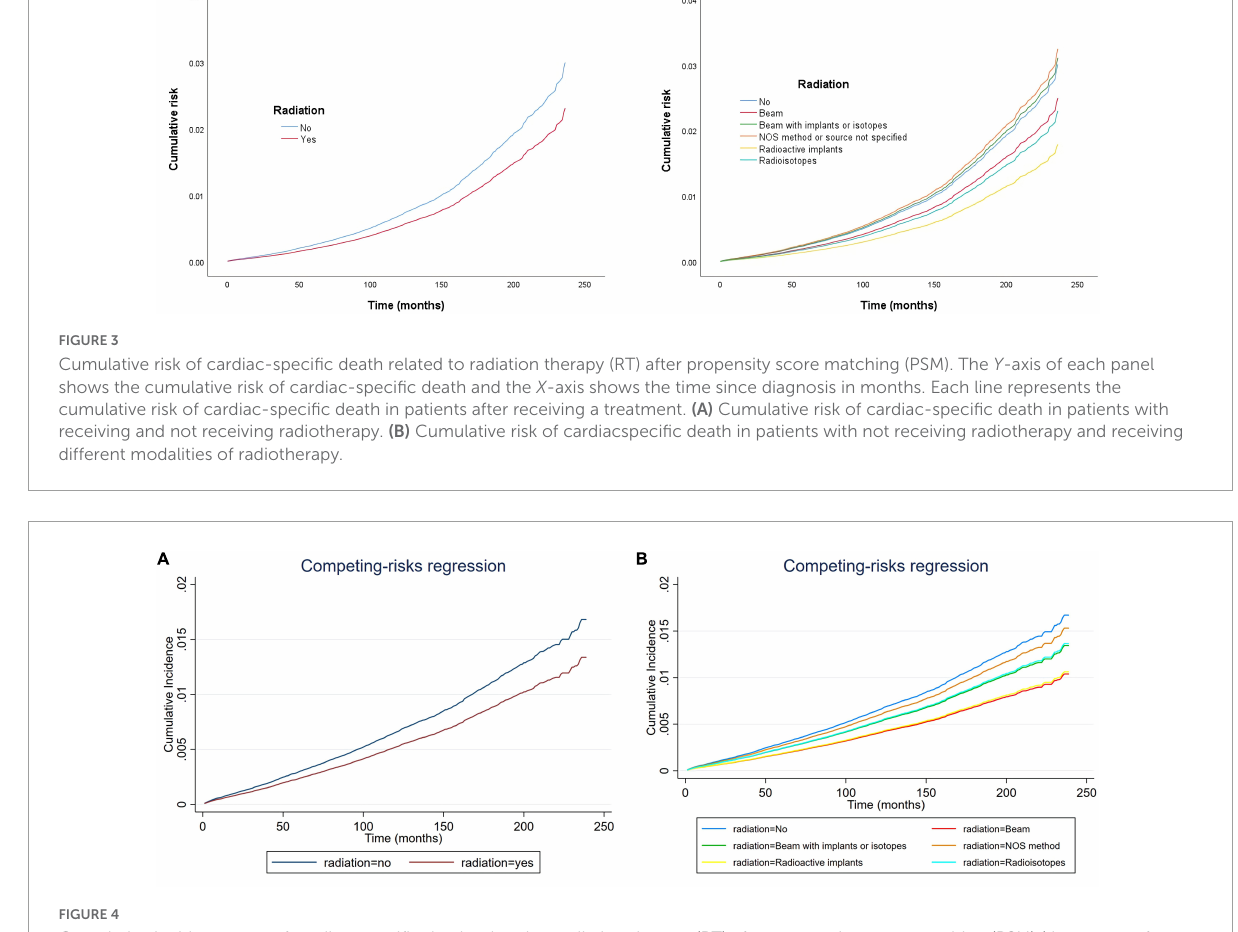
CI = 1.369–2.045, p < 0.001] vs. I), and histologic type (8050– 8059 [HR = 1.259, CI = 1.08–1.467, p = 0.003] vs. 8260–8269) were risk factors for cardiac-specific